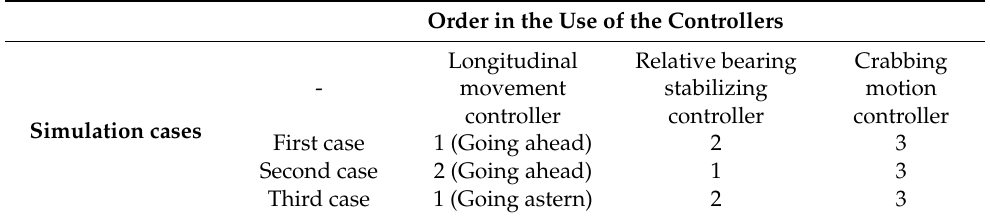
Table 8. The order in the use of the controllers for